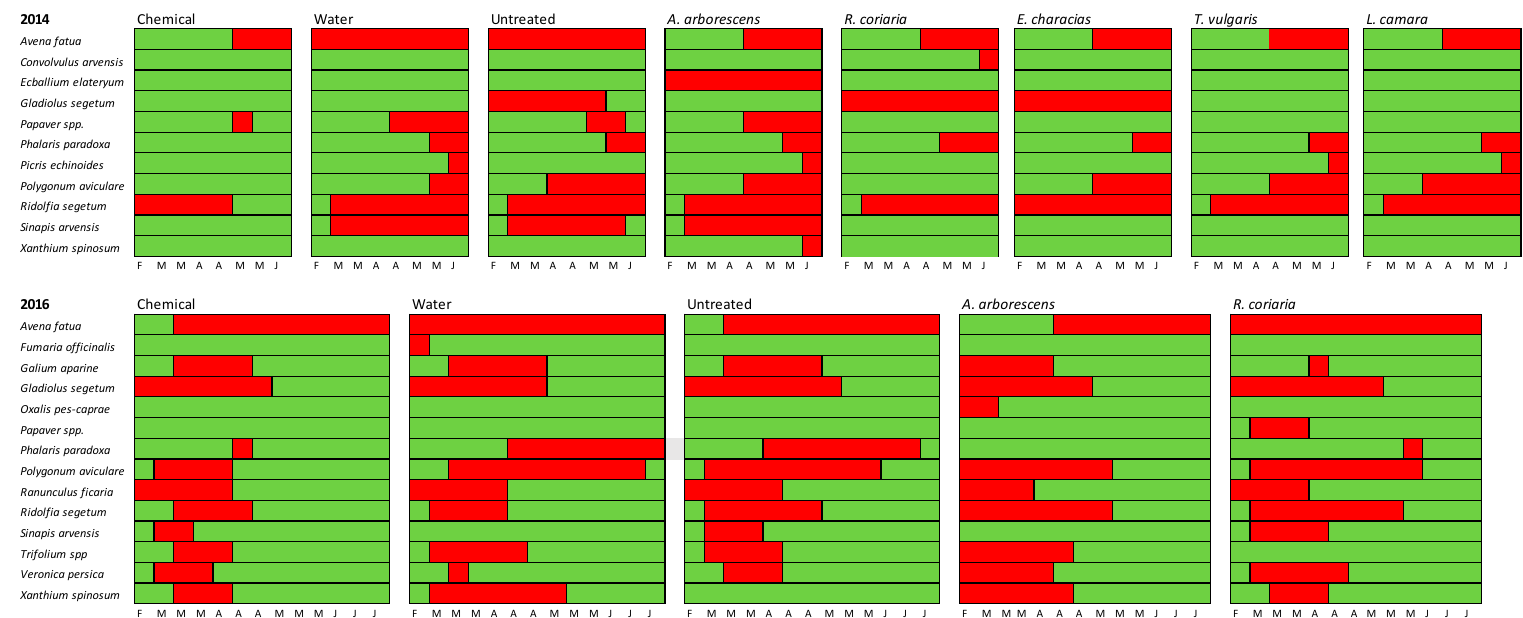
Figure 5. Time pattern of field emergence of weeds in durum wheat treated with five (2014) and two (2016) plant water extracts, compared with an untreated control, a chemical herbicide, and a control with only water. For each weed species, red areas mark the observed presence in the field from February (F) to June (J).